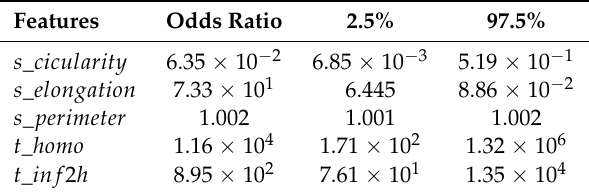
Table 1. Odds Ratio (OR) values from the model obtained by RF method.